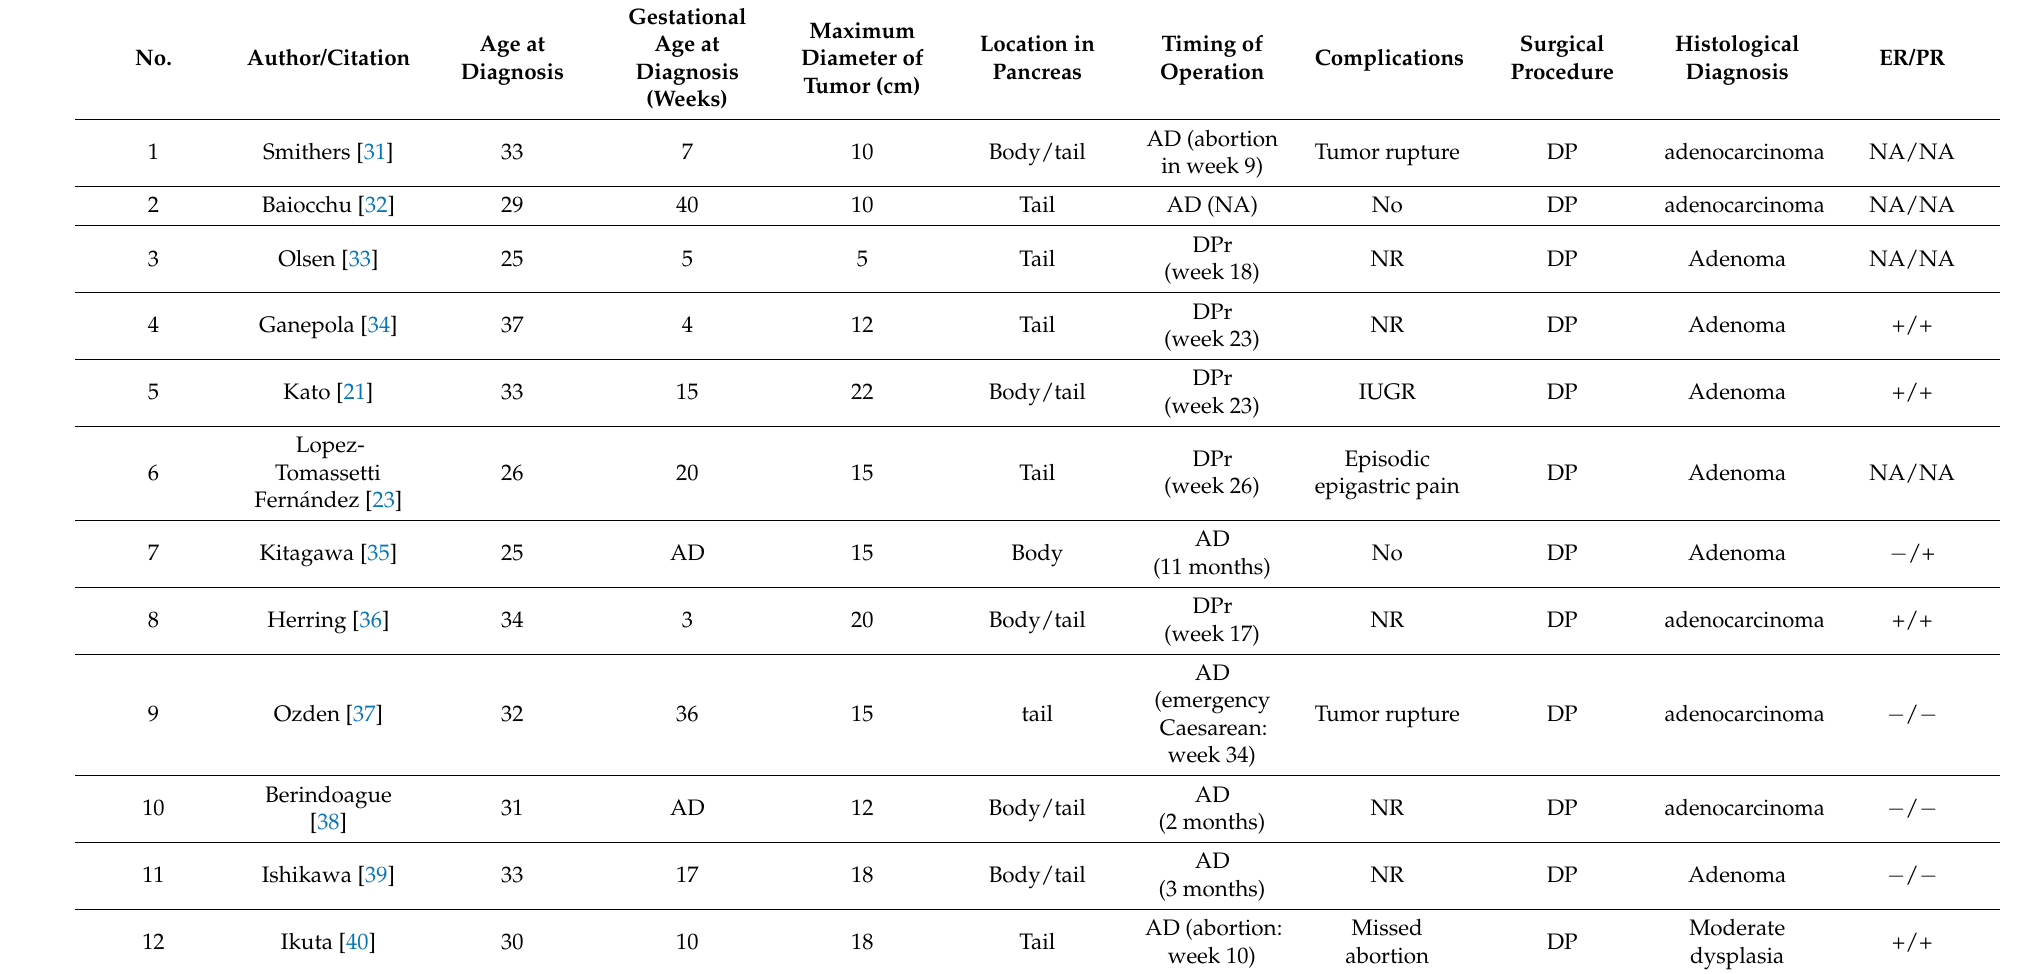
Table A1. Summary of previously reported pancreatic MCNs associated with